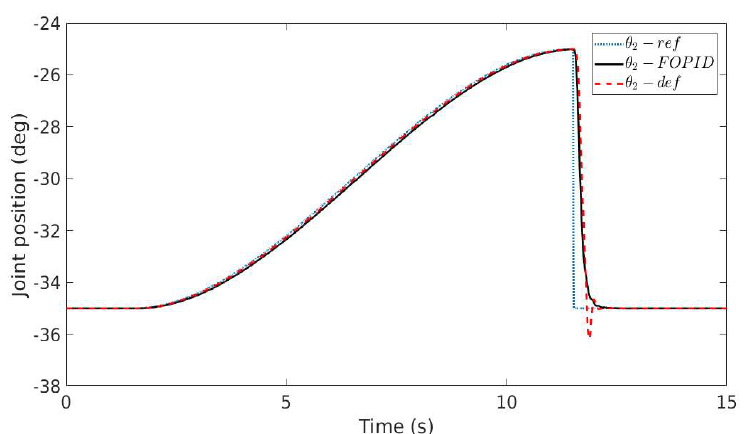
Figure 6. Step response of the UR10 robot for joint 2—the first robot configuration (ref = reference signal, FOPID = closed loop response with FO-PI controller in (23), def = default robot PID controller).